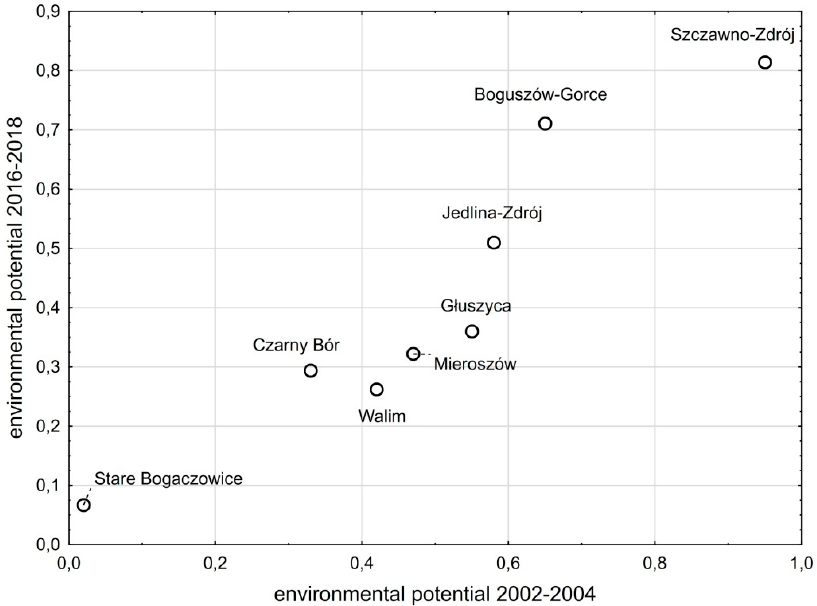
Figure 3. Scatter plot of environmental development potential in 2002–2004 vs. 2016–2018. Source: